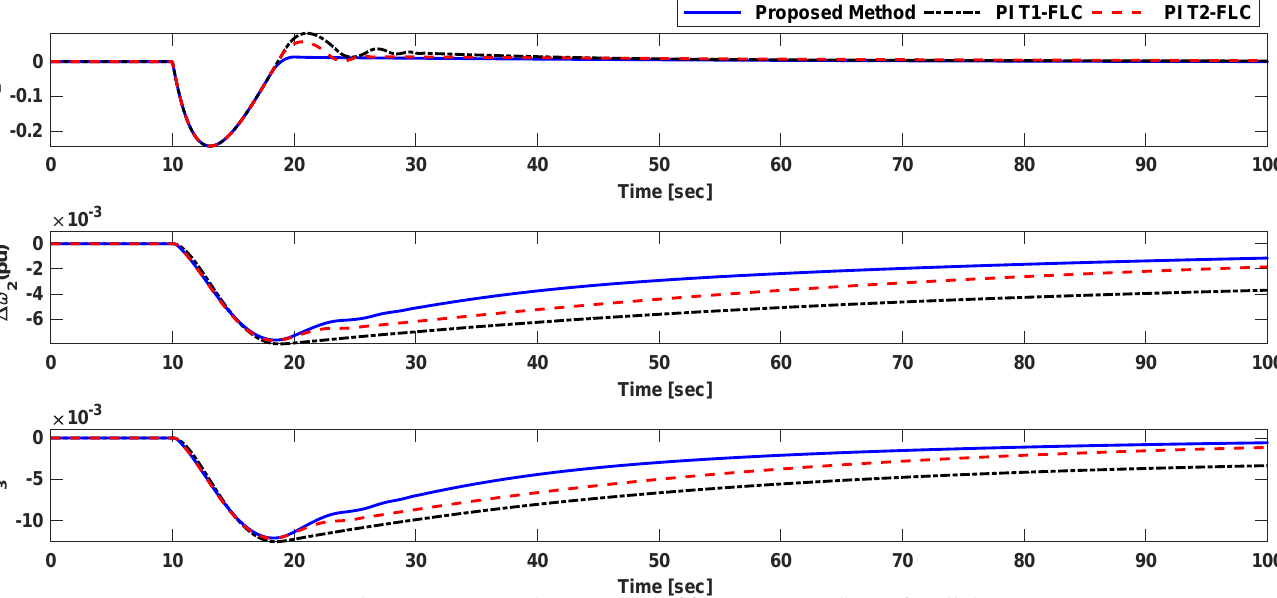
Figure 13. Example 2: Scenario 2: The trajectory of frequency regulation for all three